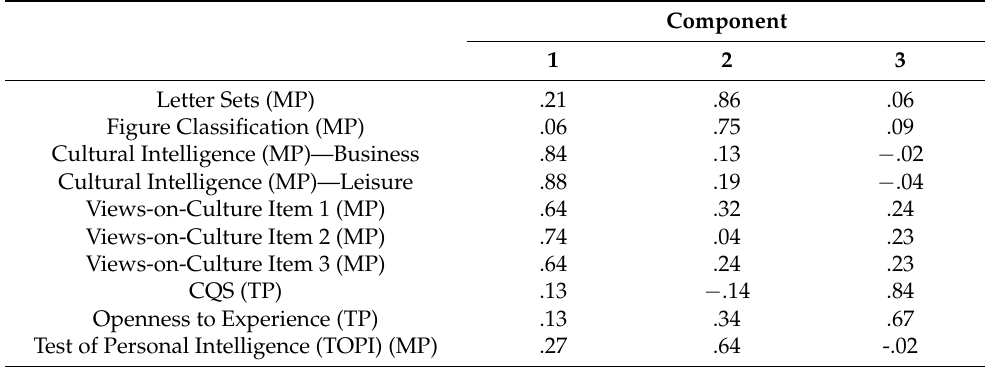
Table 6. Rotated Principal Components Matrix a : Psychometric assessments, SCIT: Business (SCIT-B) and Leisure (SCIT-L), Views-on-Culture (VC) with three items, Cultural Intelligence Scale (CQS), Openness to Experience (OE), and Test of Personal Intelligence